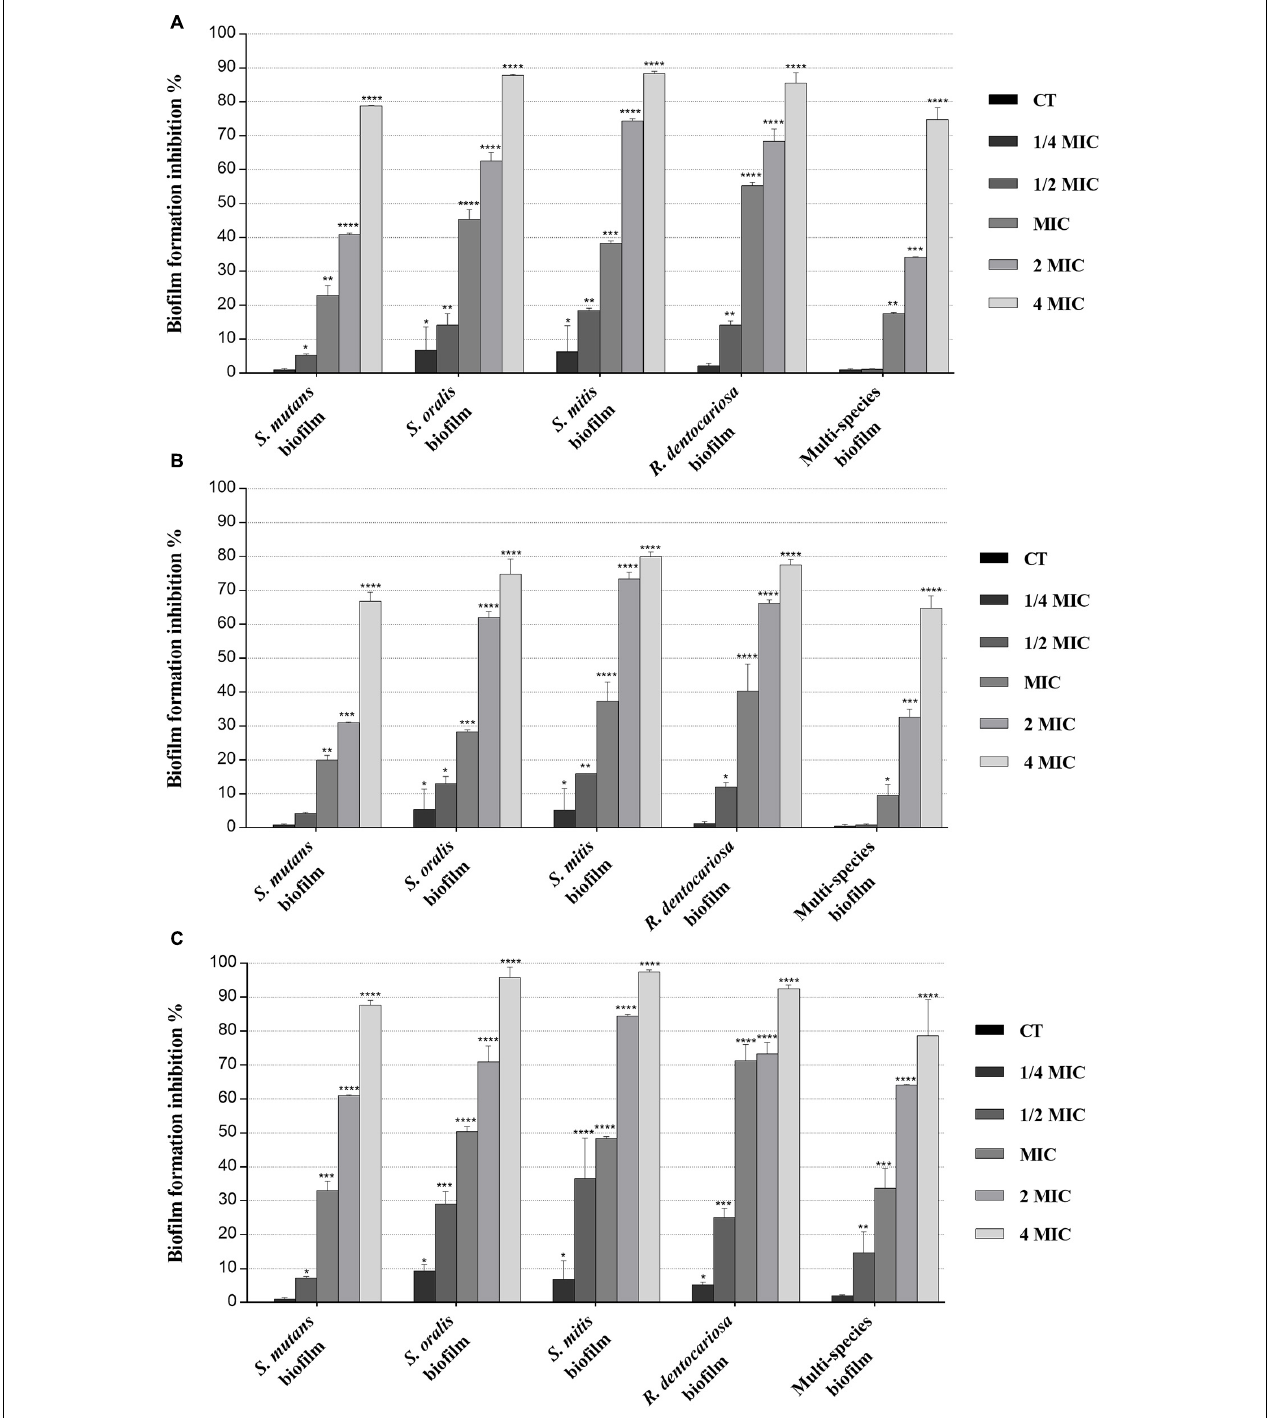
FIGURE 2 | Inhibitory effect of myrtle and pomegranate polyphenolic extracts, used individually and in binary combinations, on single-species and multispecies biofilm formation by S. mutans ATCC 25175, S. oralis SO1, S. mitis SM2, and R. dentocariosa RD1 oral isolates. Figure shows the inhibition percentage values of S. mutans ATCC 25175, S. oralis SO1, S. mitis SM2, and R. dentocariosa RD1 in single-species and multispecies biofilm (1:1:1:1 ratio for each isolate) detected, in the presence of sub-MIC (1/4 MIC and 1/2 MIC), MIC, and over-MIC (2 and 4 MIC) concentrations of myrtle leaf 50% hydroethanolic extract (MLE) (A) ; pomegranate peel 50% hydroethanolic extract (PPE) (B) ; myrtle leaf 50% hydroethanolic extract in combination with pomegranate peel 50% hydroethanolic extract (MLE + PPE) added in a 1:1 ratio (C) . The experiments were performed in triplicate with independent cultures, and statistical significance was examined by the two-way ANOVA test with Dunnett correction. Results are indicated as means ± SDs. Asterisks indicate statistical significance (* p < 0.05; ** p < 0.01;*** p < 0.001; **** p < 0.0001).